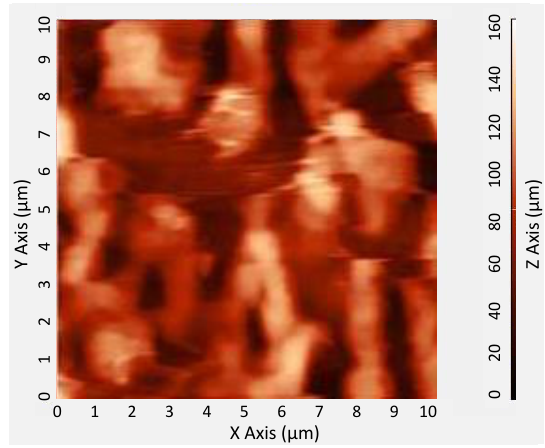
Figure 8. Surface topography description of the CrypA by AFM.